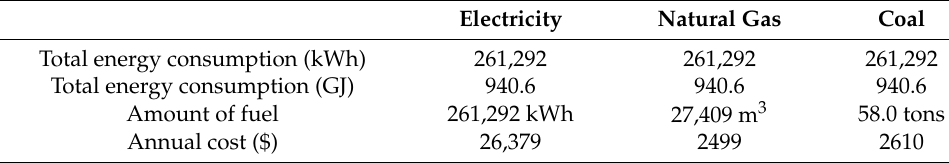
Table 4. Annual heating cost using different energy